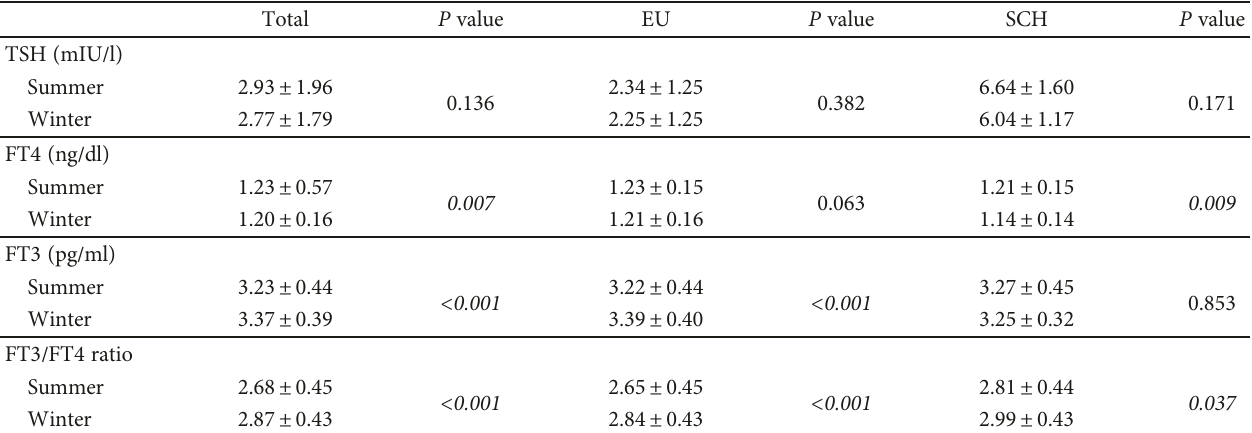
Table 3: Comparison of the serum TSH, FT4, FT3, and FT3/FT4 ratio between summer and winter season.